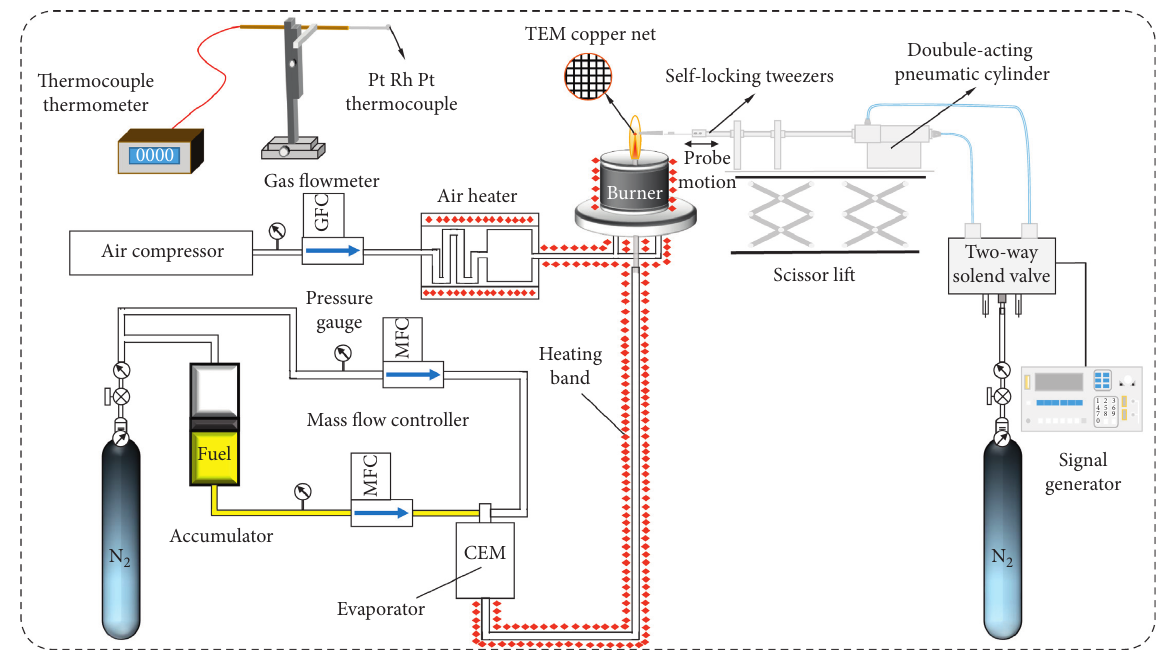
Figure 1: Schematic diagram of liquid fuel evaporative atomization combustion experiment